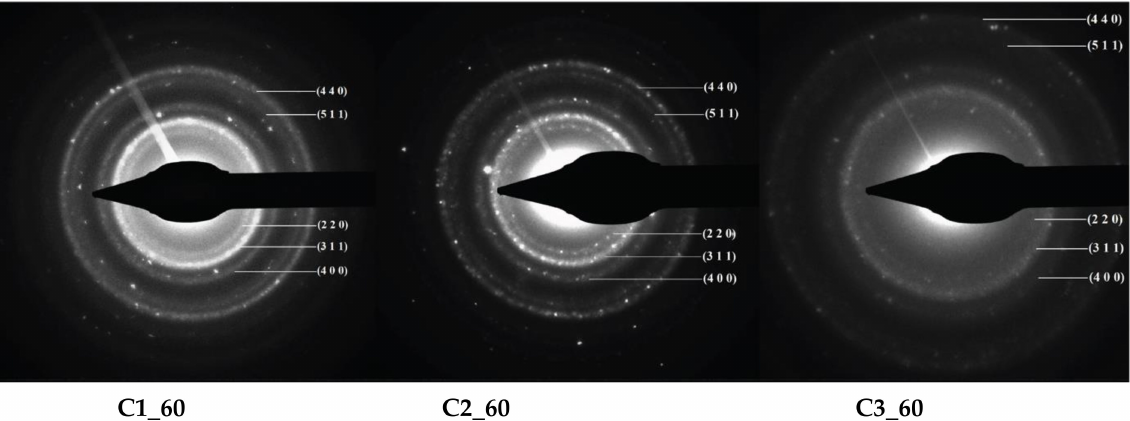
Figure 5. SAED diffraction patterns and the corresponding Miller indices for the MNPs samples.